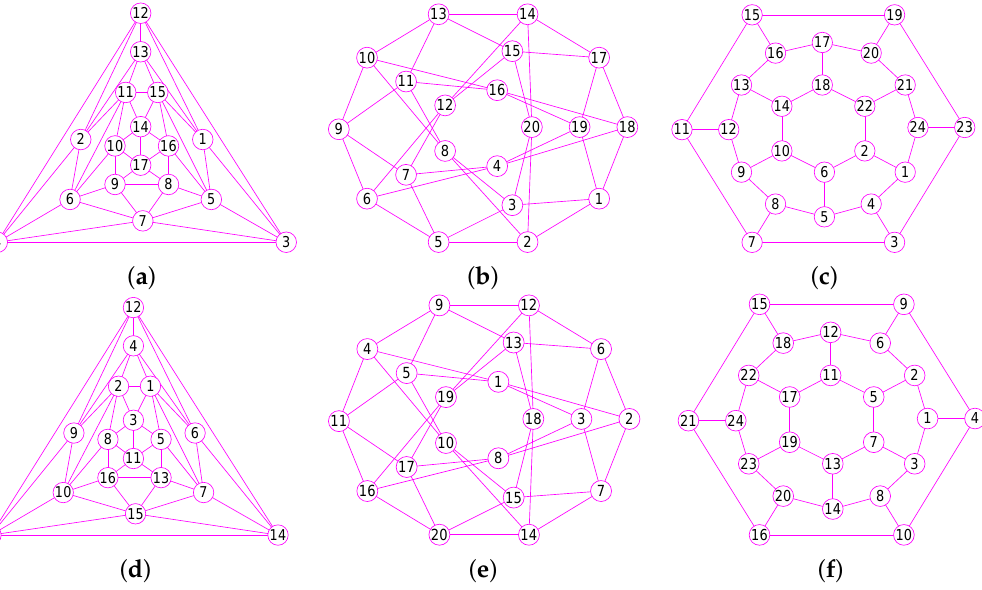
Figure 18. The TopMost graphs of three graphs G 25 , G 26 and G 27 . ( a ) The Errera graph G 25 of 17 vertices and 45 edges; ( b ) The Folkman graph G 26 with 20 nodes and 40 edges; ( c ) A fullerene graph G 27 of 24 nodes and 36 edges; ( d ) The TopMost graph of G 25 ; ( e ) The TopMost graph of G 26 ; ( f ) The TopMost graph of G 27